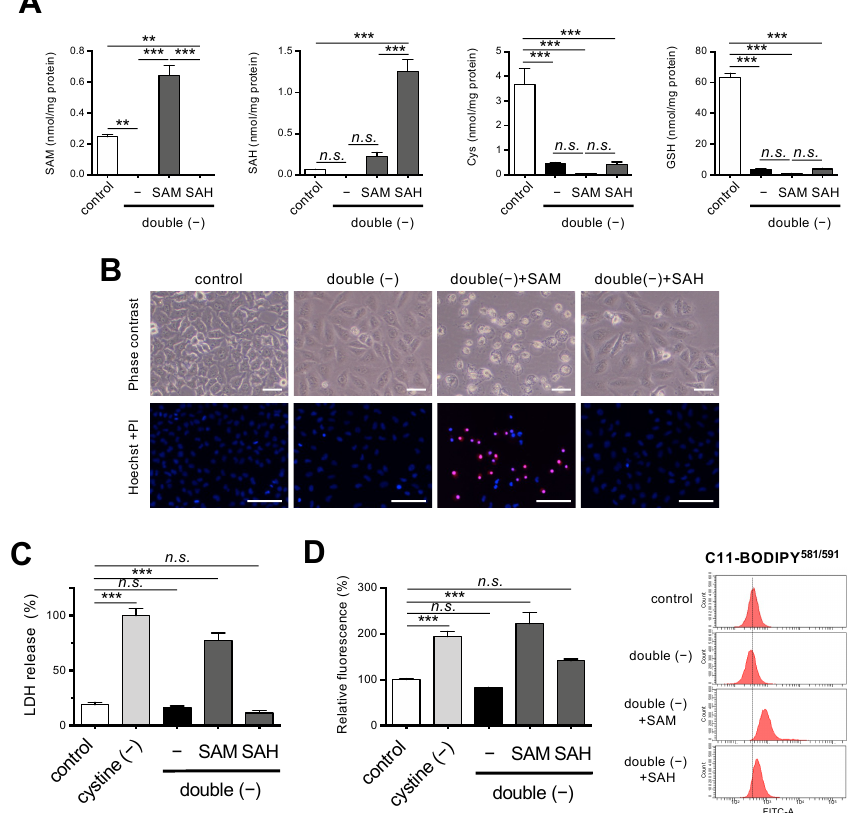
Figure 3. Effects of SAM on ferroptosis under Met/cystine double-free conditions. ( A ) Intracellular concentration of SAM, SAH, Cys, and GSH in HeLa cells 24 h after culturing in complete (control) or Met/cystine double-free medium supplemented with or without 0.2 mM SAM or 0.2 mM SAH. Data are presented as the mean ± SEM ( n = 3). ( B ) Top, representative phase-contrast images of cells that had been treated under the same conditions as ( A ). Note that SAM supplementation increased collapsed ferroptotic cells with plasma membrane rupture. Bottom, plasma membrane integrity of cells was assessed by PI staining. HeLa cells were incubated in complete (control) or Met/cystine double-free medium supplemented with or without 0.2 mM SAM or 0.2 mM SAH for 24 h. The cells were stained with PI (red) and Hoechst 33342 (blue). Bars: 100 µ m. ( C ) Cytotoxicity of cells assessed by measuring released LDH activity. HeLa cells were incubated in complete (control), cystine-free, or Met/cystine double-free medium supplemented with or without 0.2 mM SAM or 0.2 mM SAH for 24 h. Data represent the mean ± SEM ( n = 3). ( D ) Lipid peroxide production assessed by flow cytometry using C11-BODIPY 581/591 . HeLa cells were incubated in complete (control), cystine-free, or Met/cystine double-free medium supplemented with or without 0.2 mM SAM or 0.2 mM SAH for 18 h, treated with 10 µ M C11-BODIPY 581/591 , and then subjected to flow cytometry. Values for the fluorescence relative to cells cultured in control medium are shown ( n = 3). **: p < 0.01, ***: p < 0.001 (Tukey’s test). n.s.: not